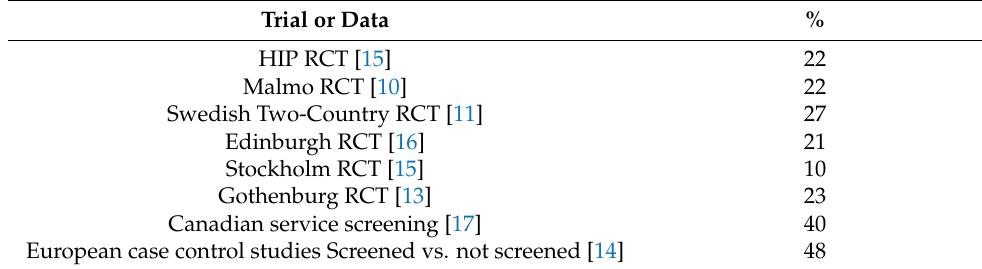
Table 1. The advantage of screening mammography for mortality reduction. Trial or Data